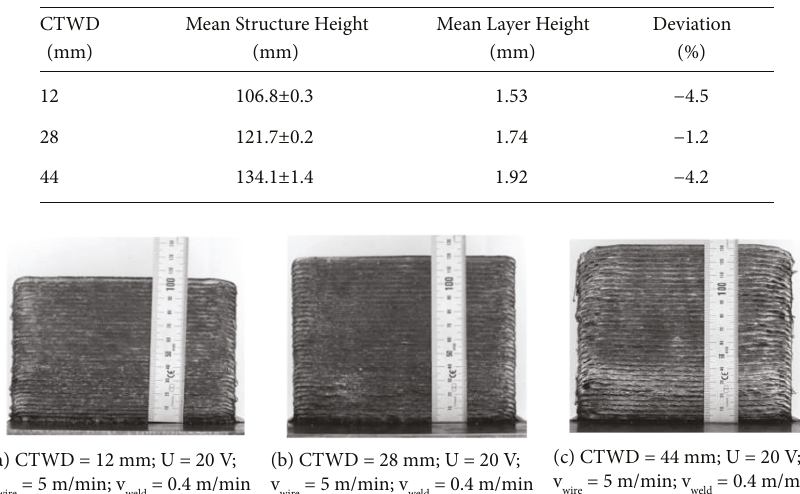
Figure 9: WAAM of wall structures with 70 layers and differing